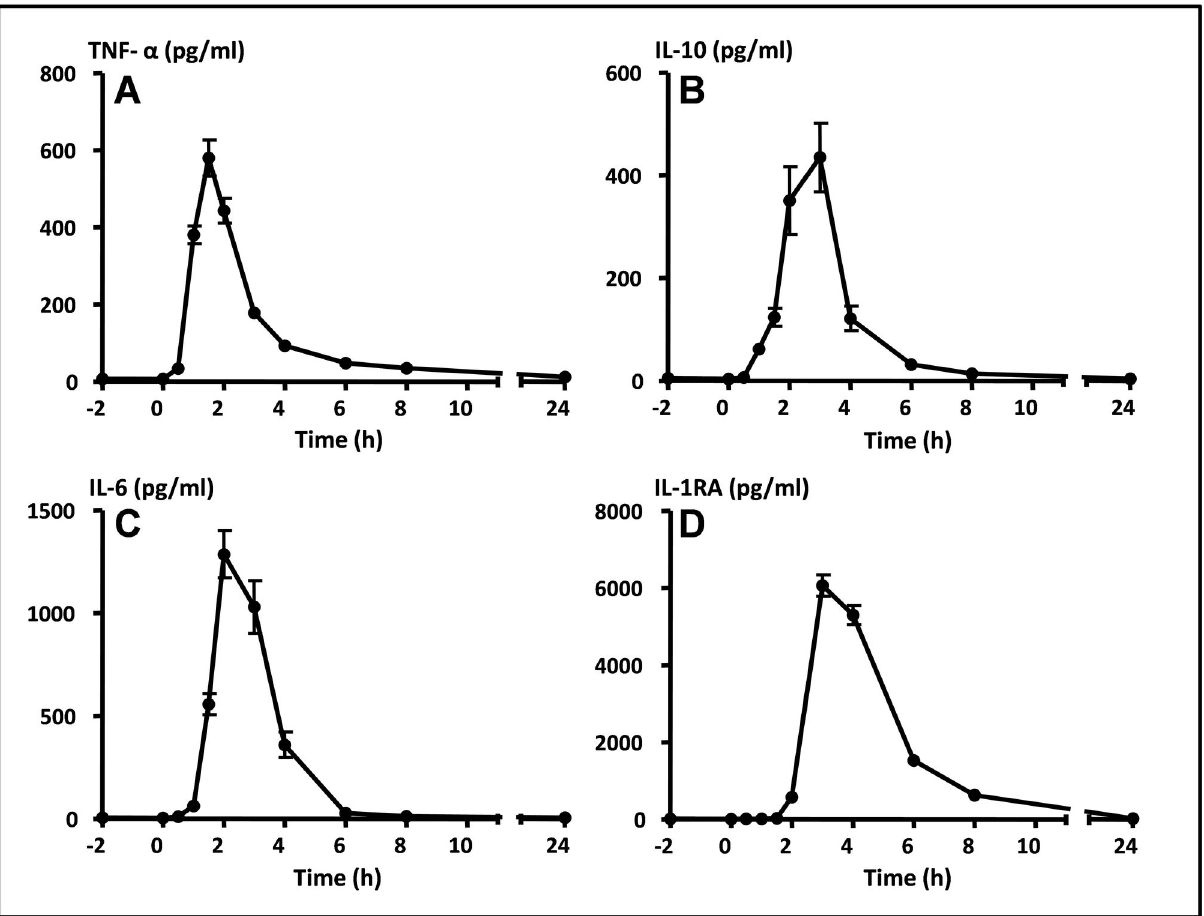
Figure 1. Plasma cytokine levels during human endotoxemia. Data expressed as mean±SEM. At T=0 h endotoxin was administered. A: TNF-α, B: IL-10, C: IL-6, D: IL-1RA. h: hours. doi: